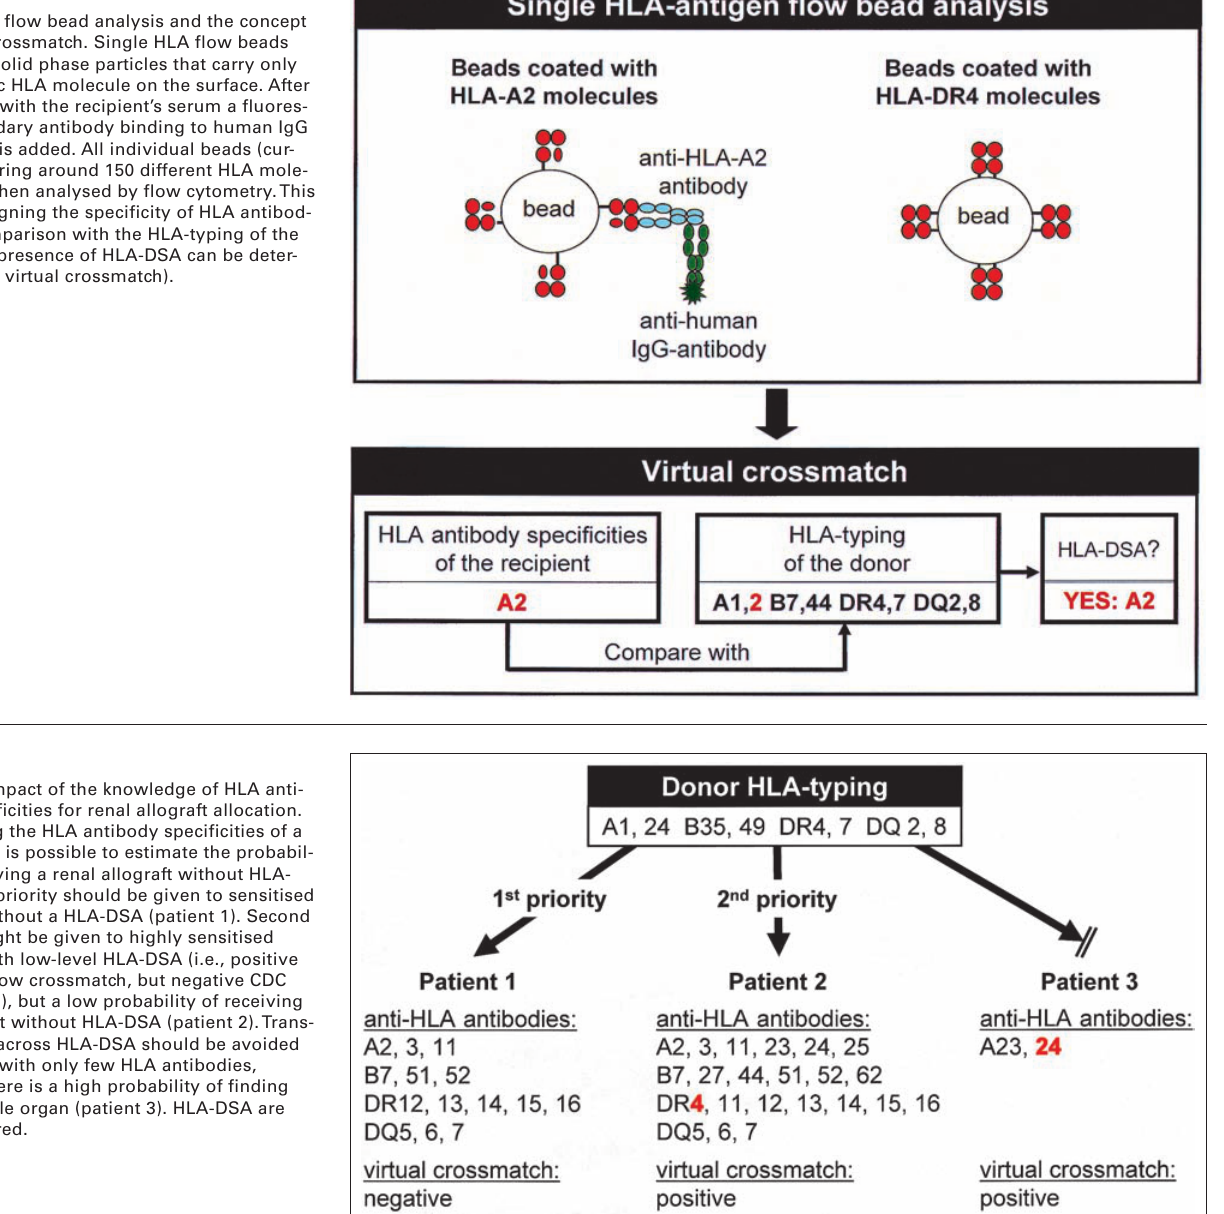
Potential impact of the knowledge of HLA anti- body specificities for renal allograft allocation. By knowing the HLA antibody specificities of a recipient, it is possible to estimate the probabil- ity of receiving a renal allograft without HLA- DSA. First priority should be given to sensitised patients without a HLA-DSA (patient 1). Second priority might be given to highly sensitised patients with low-level HLA-DSA (i.e., positive virtual or flow crossmatch, but negative CDC crossmatch), but a low probability of receiving a transplant without HLA-DSA (patient 2). Trans- plantation across HLA-DSA should be avoided in patients with only few HLA antibodies, because there is a high probability of finding a compatible organ (patient 3). HLA-DSA are marked in